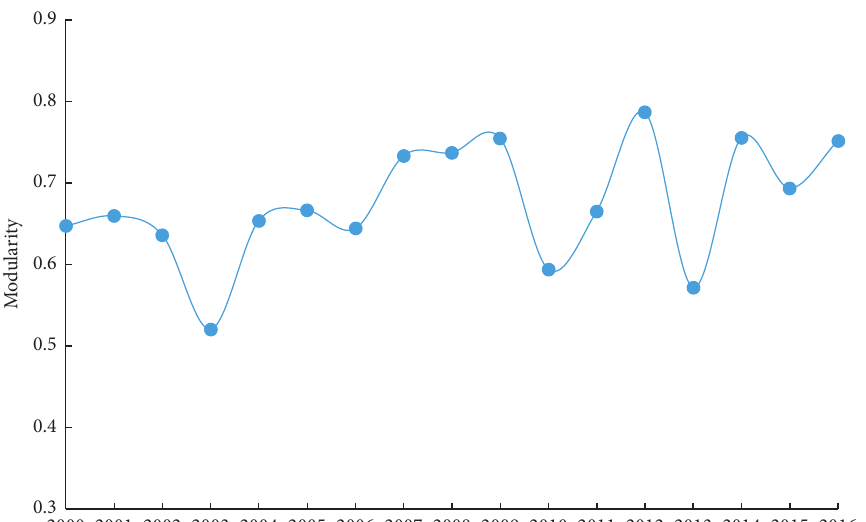
Figure 6: The dynamics of modularity from 2000 to 2020, that is, 17 cocitation networks constructed from sliding windows with a size of 5 (year) and step length of 1